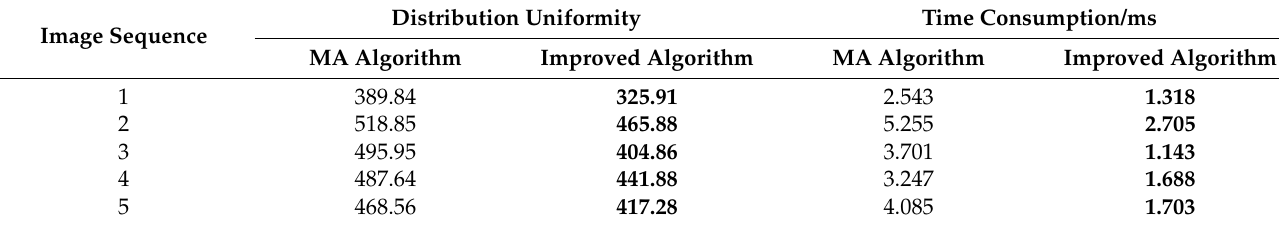
Table 1. Comparison of the uniformity and time consumption of two algorithms on the KITTI dataset sequence 00. Image Sequence